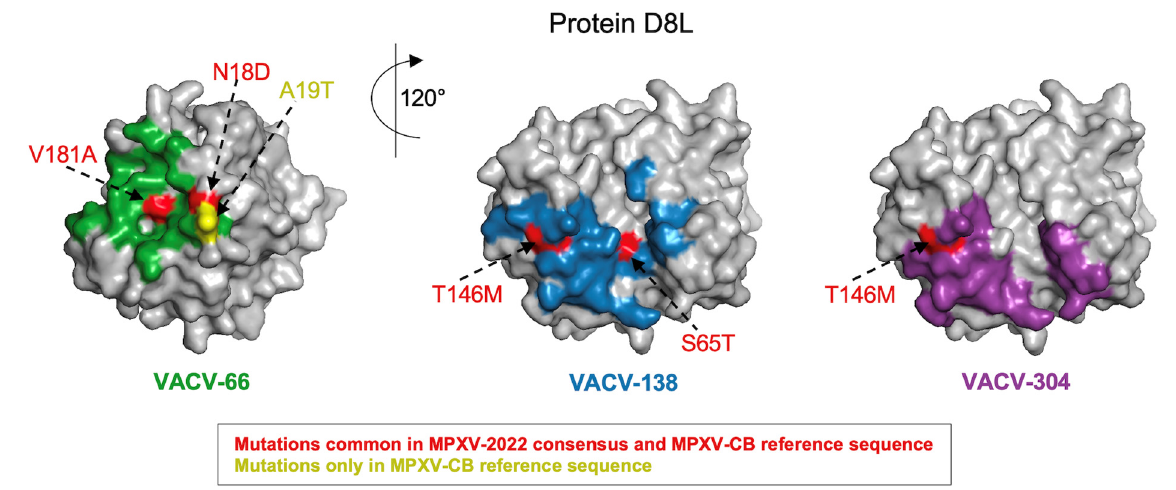
Figure 1. Mapping mutations observed in MPXV-2022 and MPXV-CB on the structure available for VACV ( A ) H3L [PDB ID: 5EJ0] and ( B ) D8L [PDB ID: 4E9O] surface proteins. The core structure of each protein is shown in gray, while mutations and their labels are colored according to the scheme in the legend.